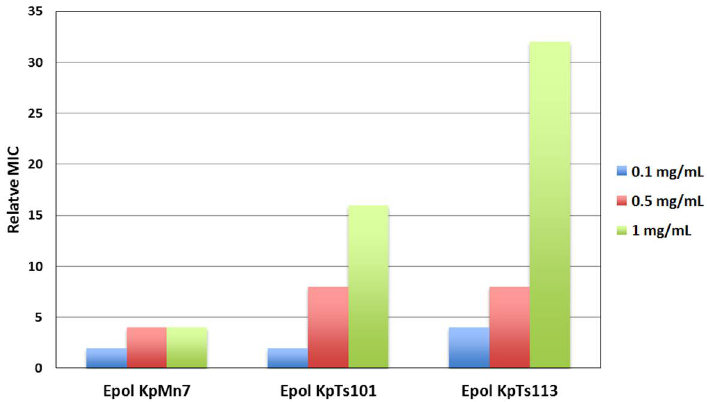
Figure 8. Relative MIC values for Bac7(1–35) against Escherichia coli ML-35 in the presence of different concentrations of K. pneumoniae EPOLs. The relative MIC is the ratio between the MIC value in the presence and in the absence of the polysaccharide. The MIC value in the absence of polysaccharides was 2 μM. The values were obtained from three independent experiments.